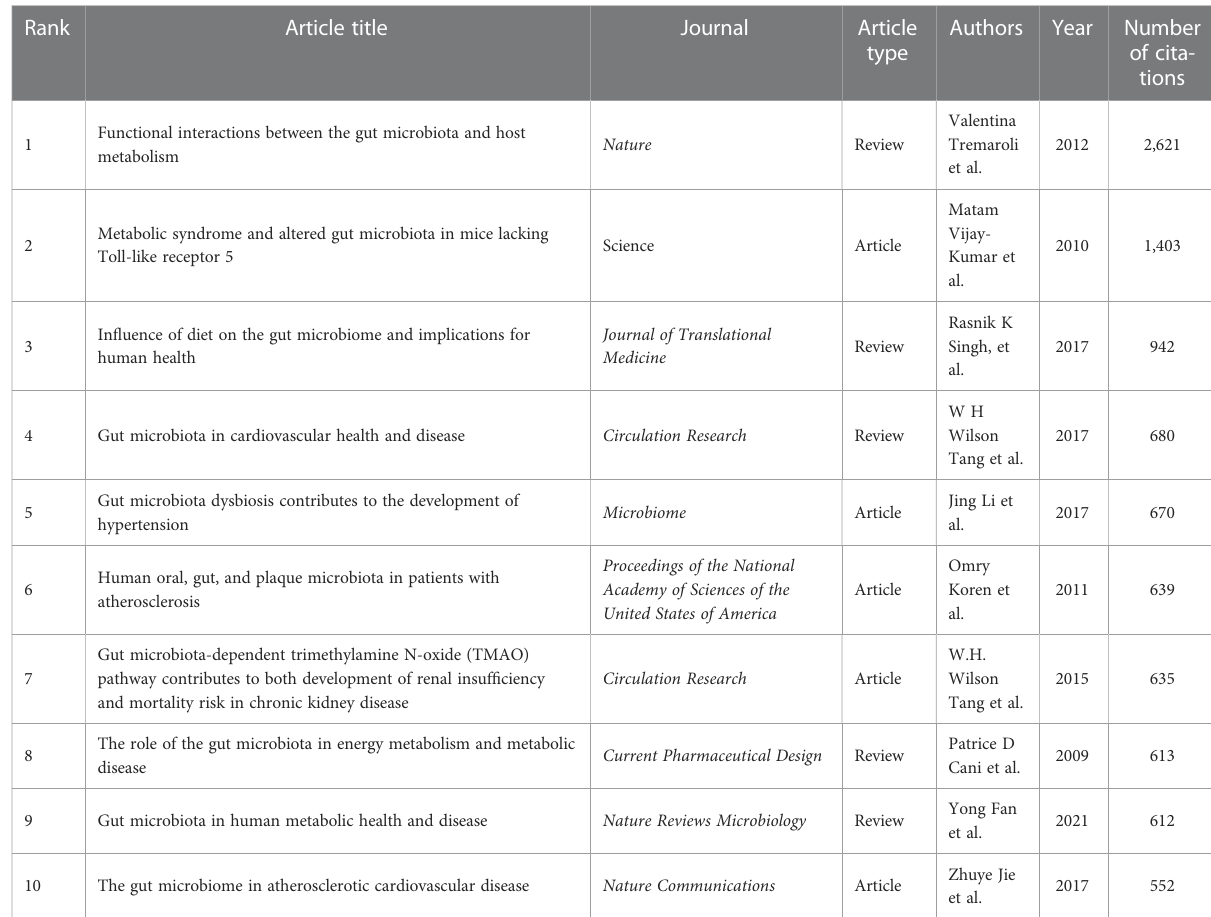
TABLE 6 The top cited publications of GM in